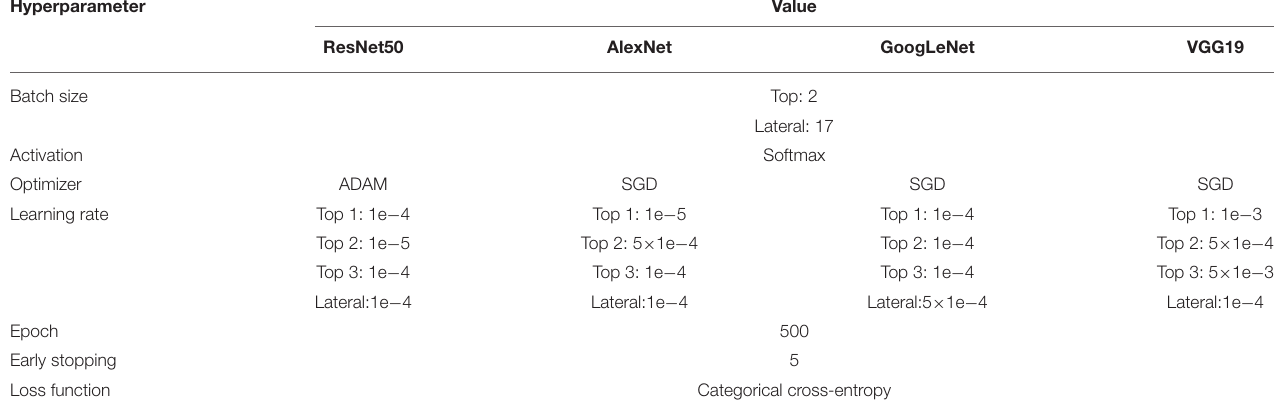
TABLE 3 | Optimized hyperparameter for model